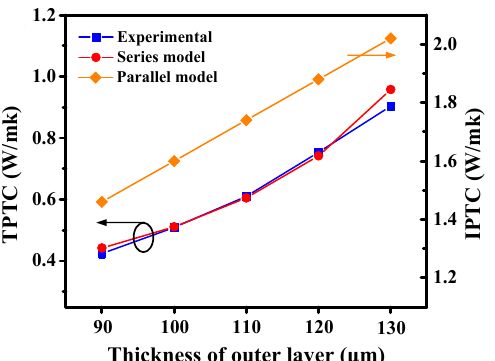
Figure 4. The experimental and theoretical thermal conductivity in a sandwich composite.